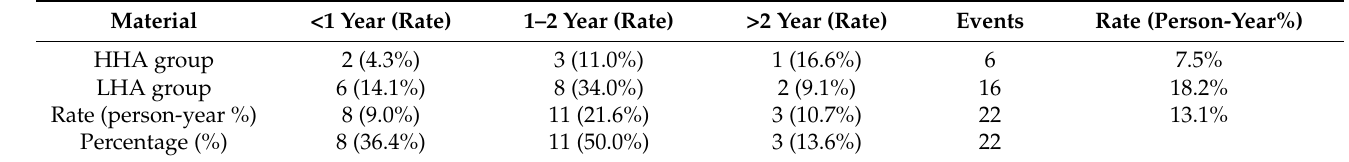
Table 3. Incidence rate of secondary procedures between the two HA